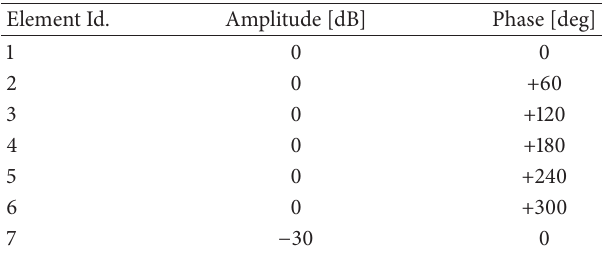
Table 4: Excitation synthesized coefficients of pattern shown in Figure 13. Element Id.